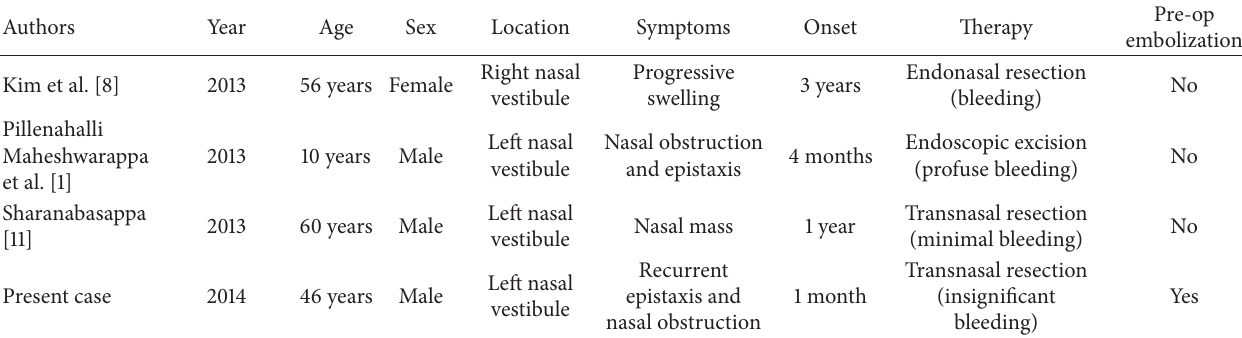
Table 1: Reported cases of vestibular extranasopharyngeal